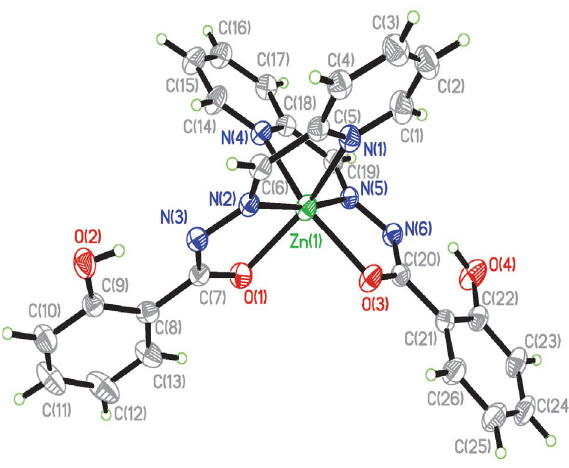
Figure 3. A perspective view of complex 3 with the atom labeling scheme. Thermal ellipsoids are drawn at the 30% probability level.